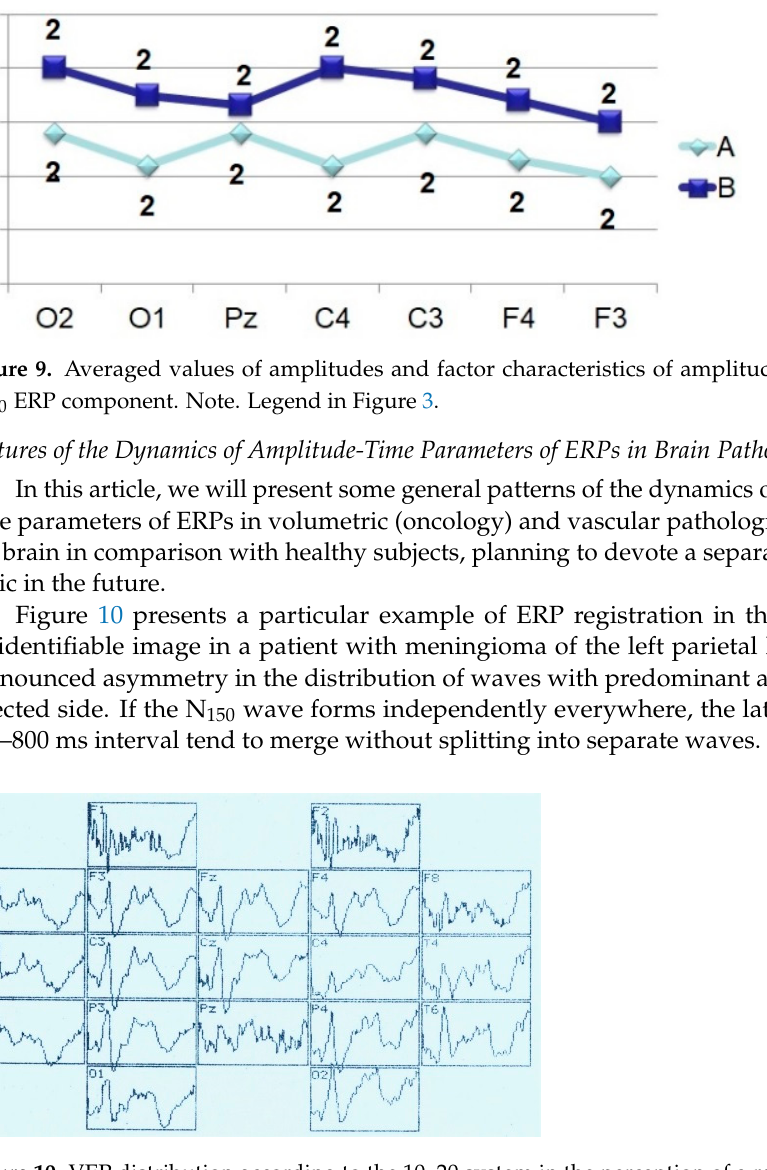
Figure 10. VEP distribution according to the 10–20 system in the perception of a recognizable